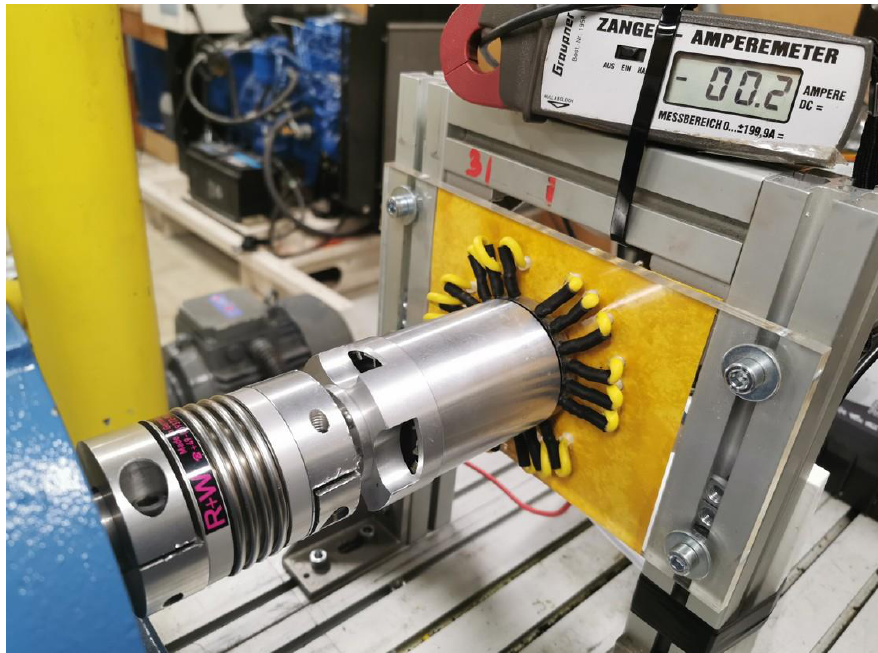
Figure 10. Interconnection of the BLDC motor with a dynamometer.